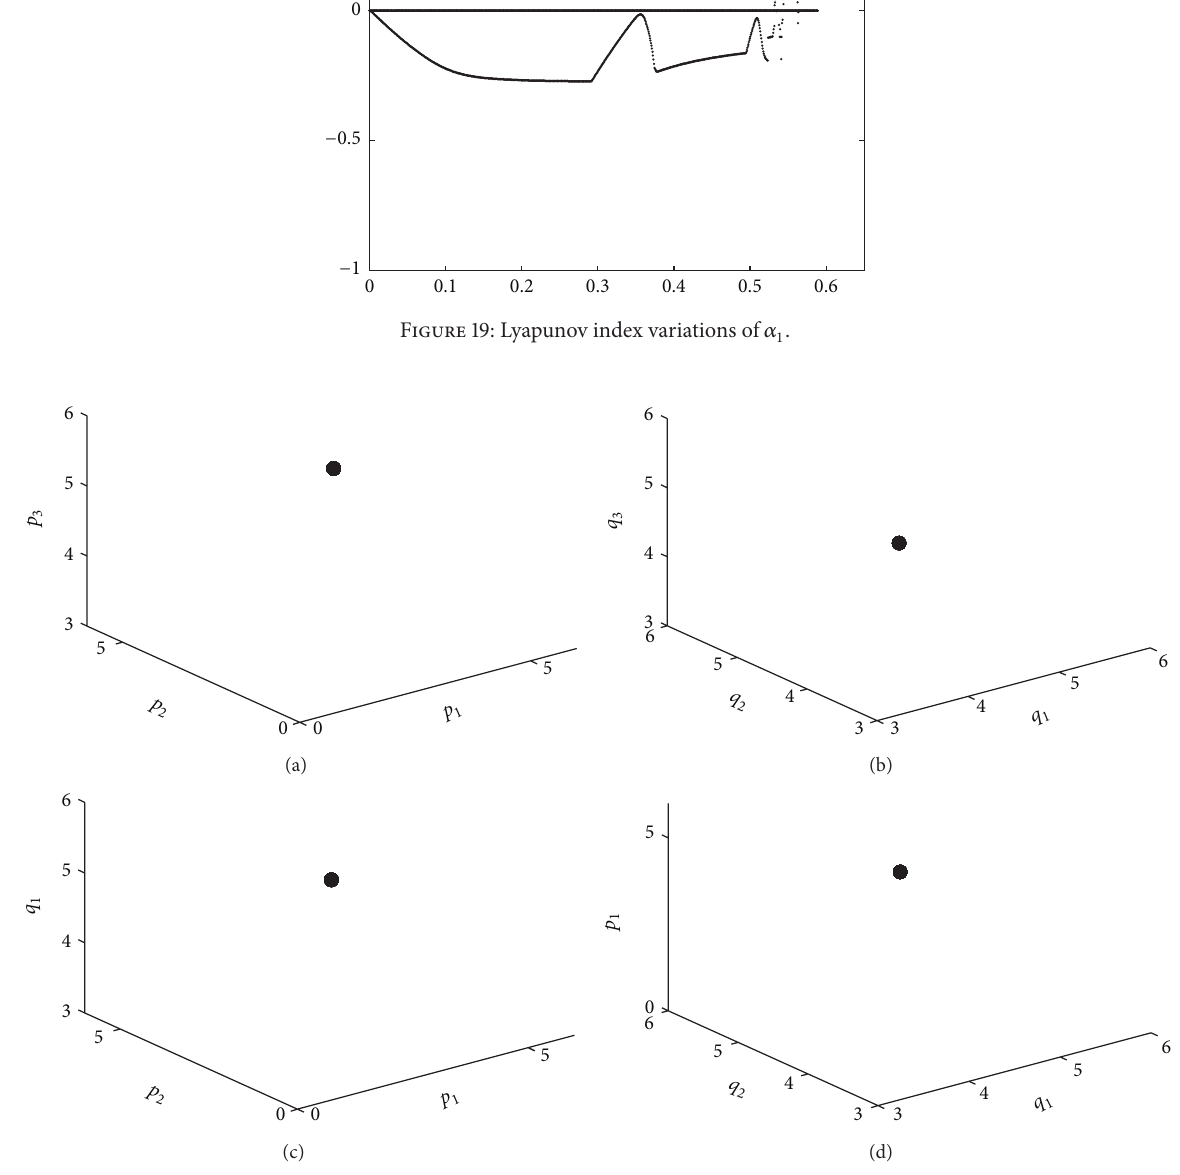
Figure 20: Chaos attractor of the system after